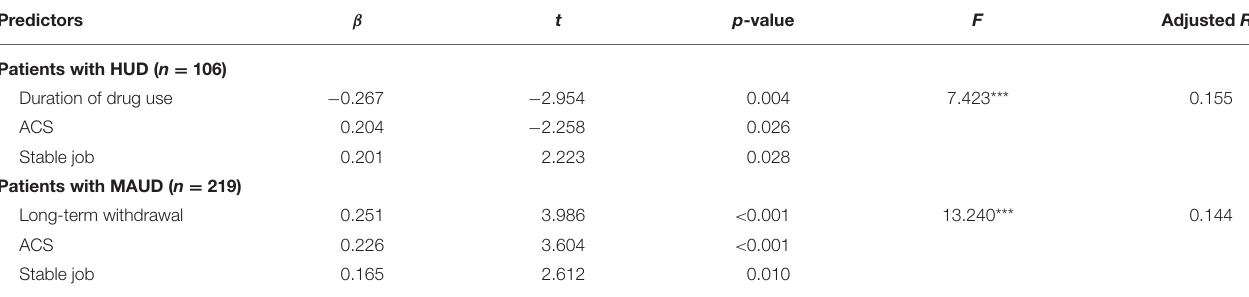
TABLE 4 | Multiple linear regression of clinical variables to positive affect in the two groups of patients. Predictors β t p -value F Patients with HUD ( n =